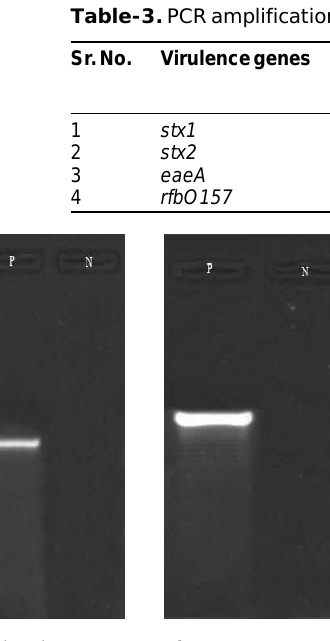
Figure-3. Agarose gel showing PCR amplified product (384 bp) for eaeA gene in E. coli isolates. P: Positive control, N: Negative control, L: DNA Ladder,